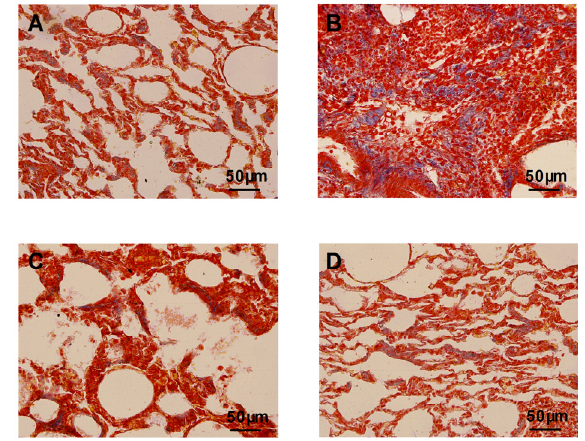
Figure 2. Effects of atorvastatin on histopathogical changes of bleomycin-induced lung with Masson’s trichrome stain (×400). ( A , D ) Lung tissue sections of control and atorvastatin alone administrated animals with normal lung morphologies: scarcely deposited collagen in the lung parenchyma; ( B ) Lung tissue sections of bleomycin-induced animals showing dense collagen accumulations: collagen accumulations in lung parenchyma; and ( C ) Lung sections of atorvastatin treated animals showing reduced collagen depositions: reduced alveolar thickening with meager